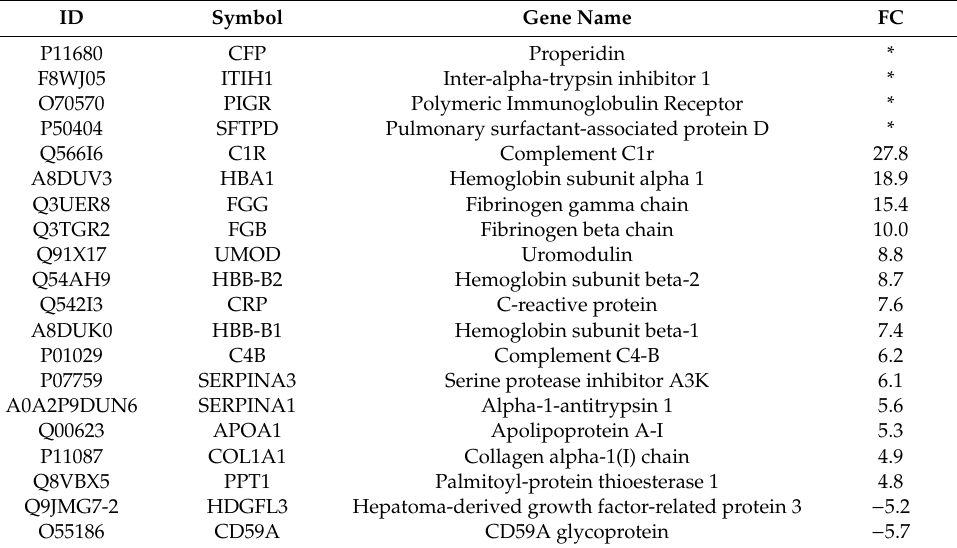
Table 1. Significantly dysregulated genes in miR-193a-overexpressing glomeruli.